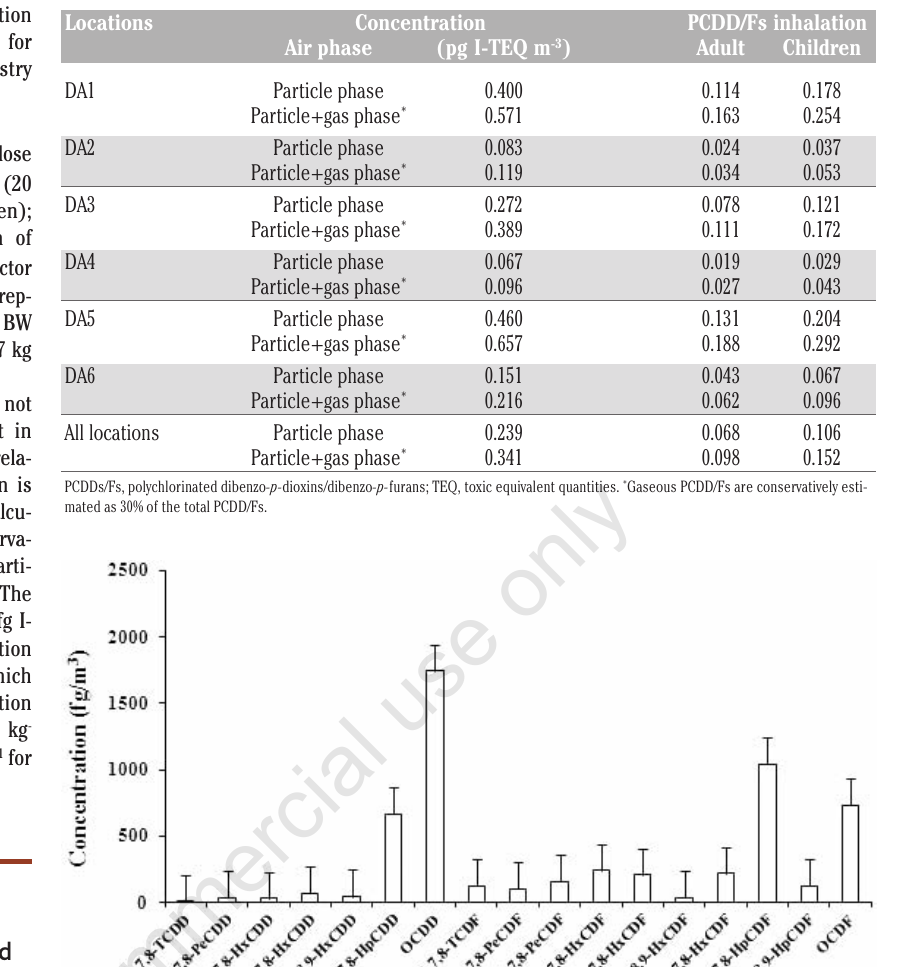
Table 3. Rough assessment of inhalation risk (pg I-toxic equivalent quantities kg -1 day -1 ) of polychlorinated dibenzo -p- dioxins/Fs in